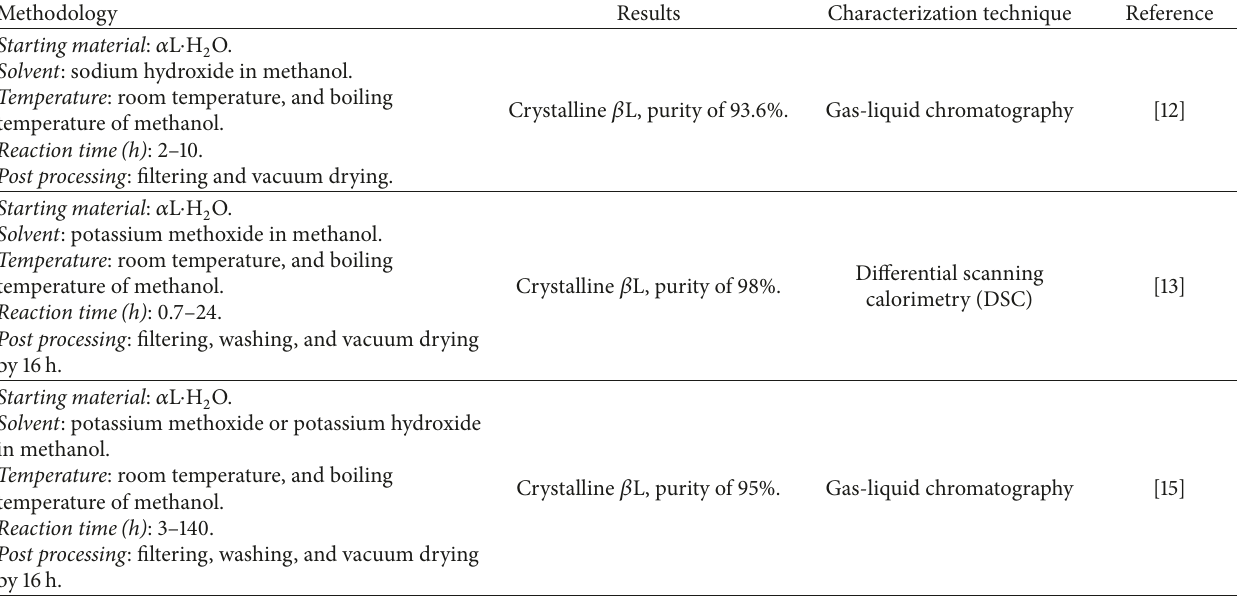
Table 1: Summary of the methodologies reported for the conversion of 𝛼 L ⋅ H 2 O into 𝛽